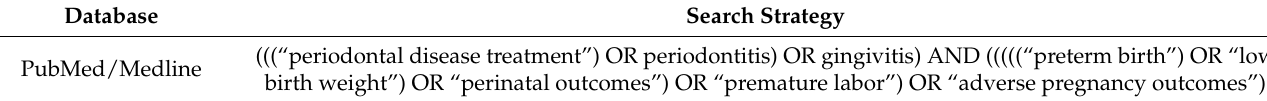
Table 1. Search strategies for each